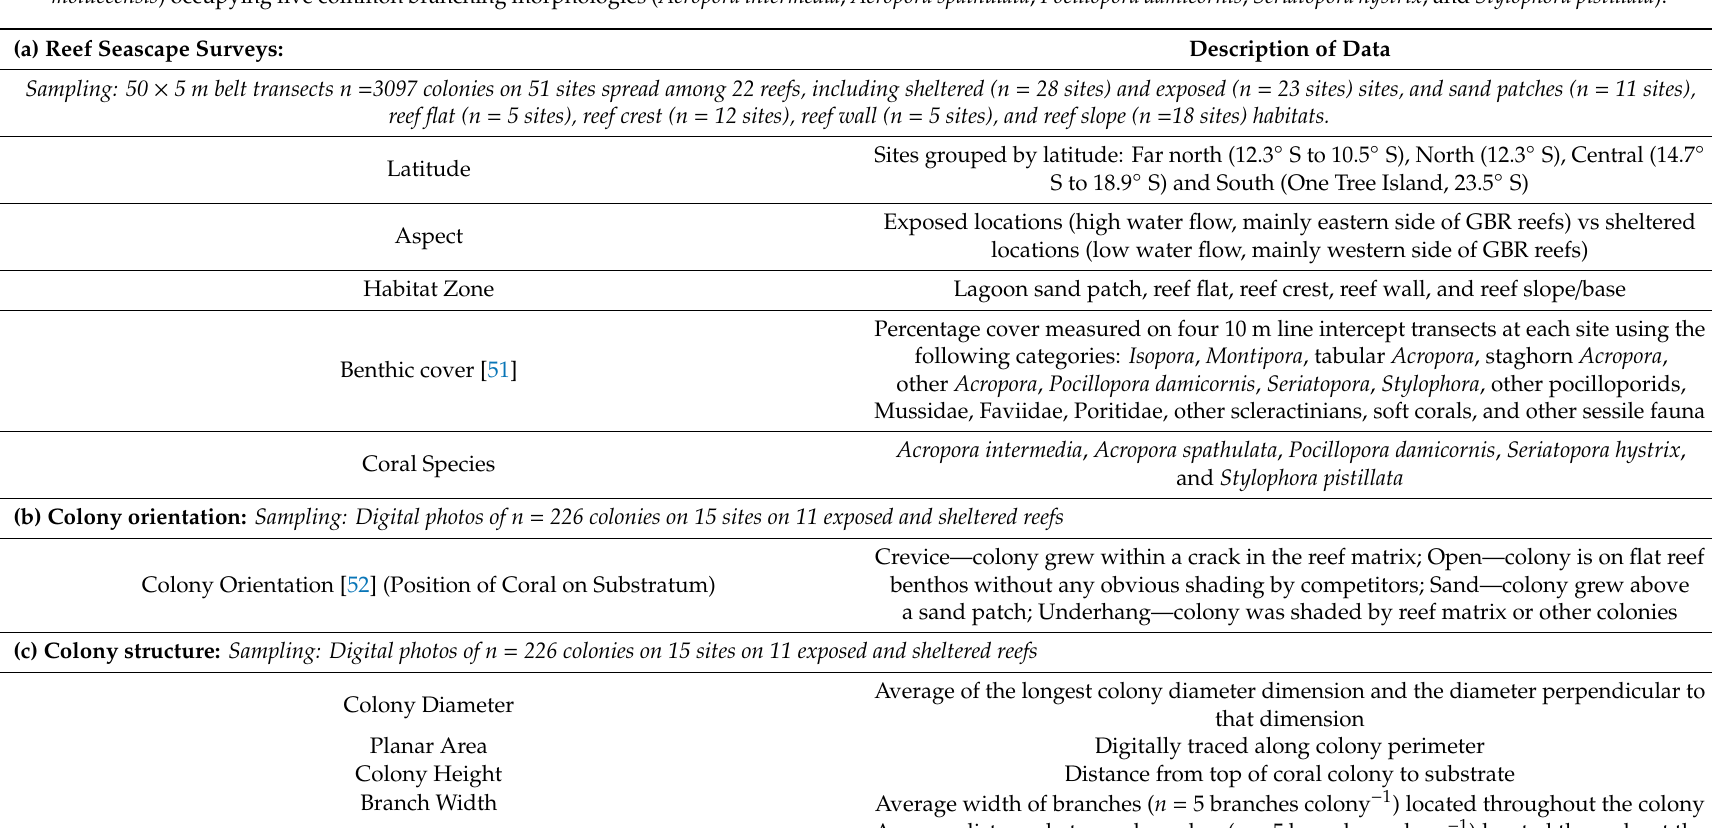
Table 1. Dataset summaries detailing the (a) observed site features quantified for 51 sites, and the individual coral (b) colony orientation, and (c) colony structure for 226 individual colonies with and without resident damselfish (occupancy and biomass as independent variables) on mid-shelf and o ff shore GBR reefs. Coral-fish interactions were focused on five focal fish species ( Chromis viridis , Dascyllus aruanus , Dascyllus reticulatus , Pomacentrus amboinensis , and Pomacentrus